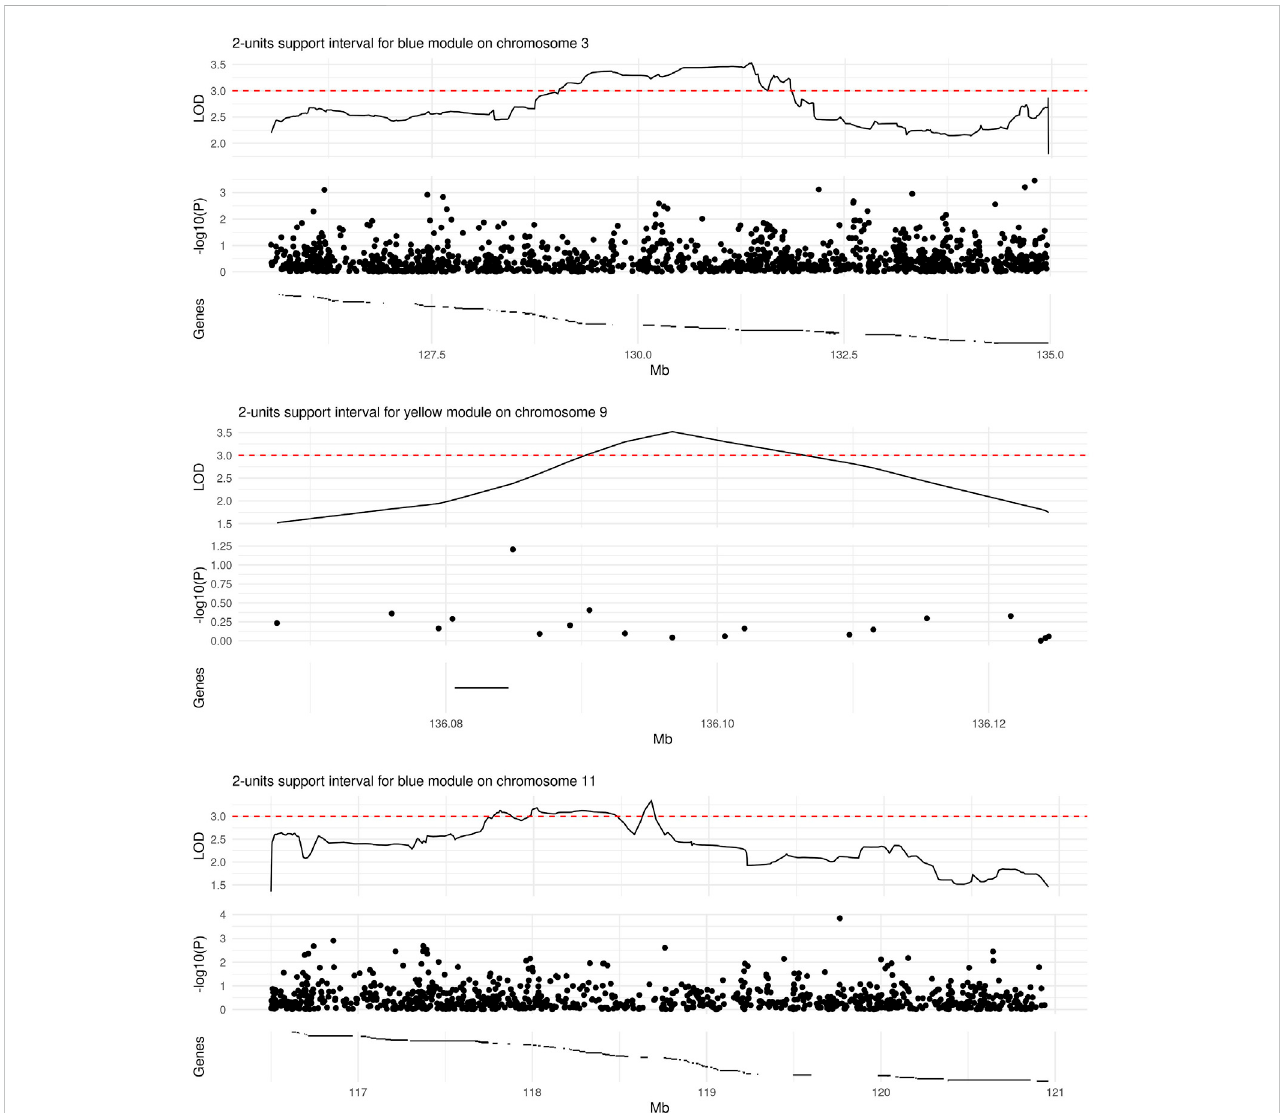
FIGURE 4 Regions of signi fi cant linkage with microbial module QTs. The locus zoom plots span the 2-units support intervals of a given genome-wide signi fi cant linkage signal. Depicted are the LOD score (top panel), p -value (on the log10 scale) from a SNP-wise association analysis (central panel), and the location of protein-codinggenes(bottompanel).Therangeofagivengeneismarkedbyahorizontalline;region-wiselistsofgenenames(fromlefttoright)areprovided in Supplementary Table